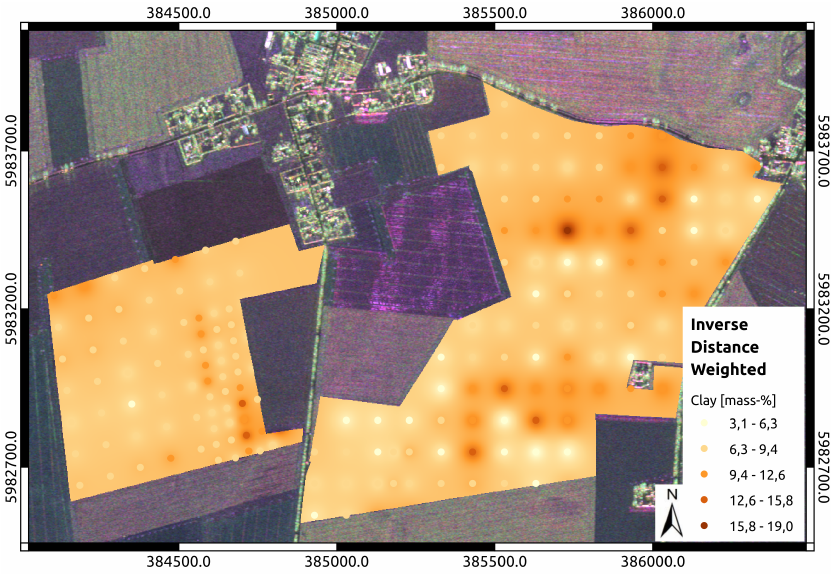
Figure 16. Spatial interpolated soil map for the texture class clay based on the IDW approach. Circles display the sample locations and colors are scaled in the same color as background clay